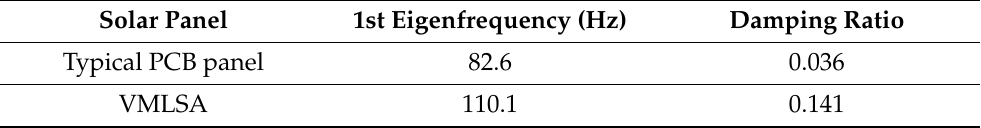
Table 7. Free-vibration test results of the solar panels in rigidly mounted condition.